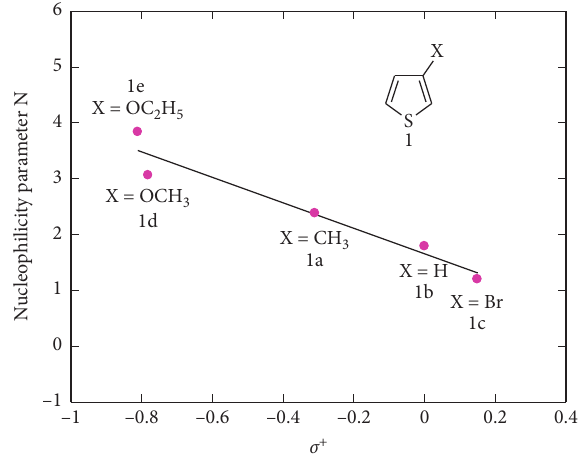
Figure 9: Correlation N � f ( σ + ) of a series of 3-X-substituted thiophenes in acetonitrile at 20 °